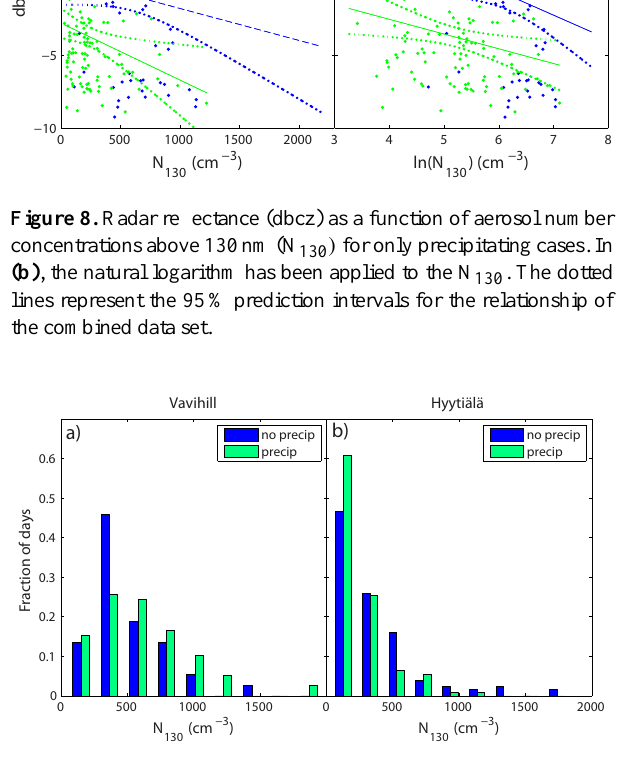
Figure 9. Histograms of aerosol number concentrations for parti- cles larger than 130nm (N 130 ) , subdivided according to precipi- tating and non-precipitating cases for (a) Vavihill and (b) Hyytiälä. Precipitating cases are defined as cases with more than 4 pixels with dbcz greater than − 10dbZ.